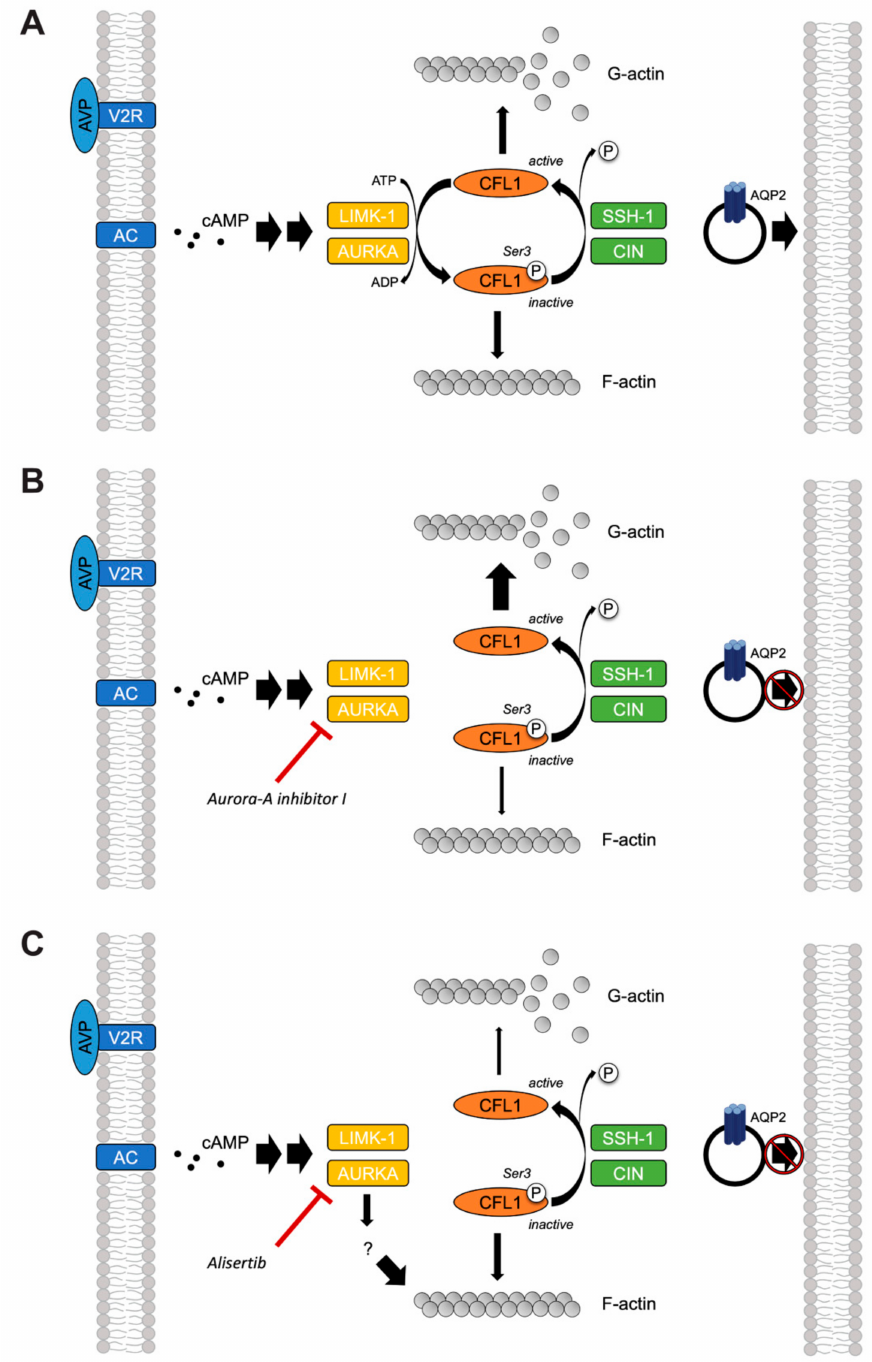
Figure 13. Aurora-A inhibitor I and Alisertib inhibit the redistribution of aquaporin-2 (AQP2) in renal principal cells by different mechanisms. ( A ) Under physiological conditions, the binding of arginine-vasopressin (AVP) to the vasopressin V2 receptor (V2R) activates adenylyl cyclase (AC) and increases intracellular cyclic adenosine monophosphate (cAMP). The redistribution of AQP2 to the plasma membrane involves actin remodeling. The actin regulatory protein cofilin-1 (CFL1) is phosphorylated (P) at serine (Ser) 3 and thereby inactivated by LIM kinase 1 (LIMK-1) and Aurora kinase A (AURKA). Inactive CFL1 promotes the formation and maintenance of filamentous (F-)actin stress fibers. The depolymerization of F-actin into globular (G-)actin monomers is induced after reactivation of CFL1 by dephosphorylation by slingshot phosphatase 1 (SSH-1) and chronophin